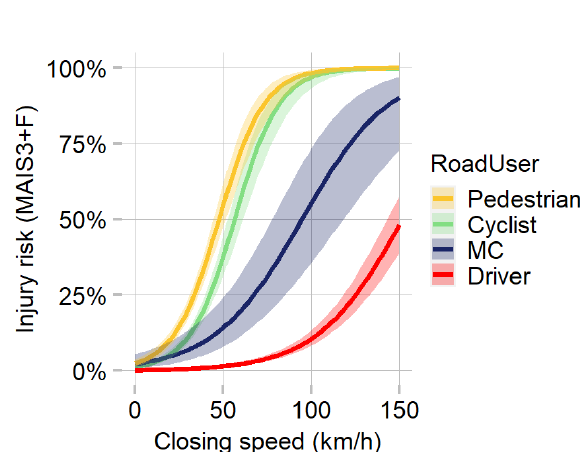
Figure 6. MAIS3+F injury risk curves with confidence levels, for different road users at 65 years of